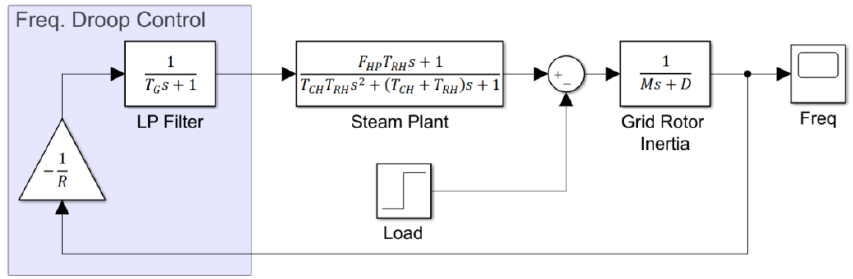
Figure 1. Conventional frequency droop control diagram adopted from Reference [7].